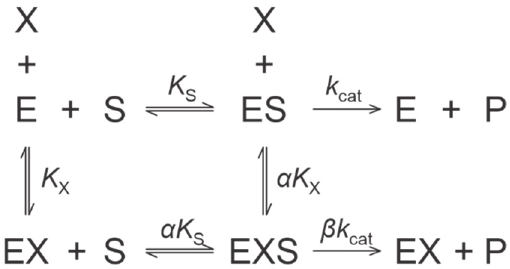
Scheme 1. General modifier mechanism for the interaction between enzyme (E), substrate (S) and modifier (X).